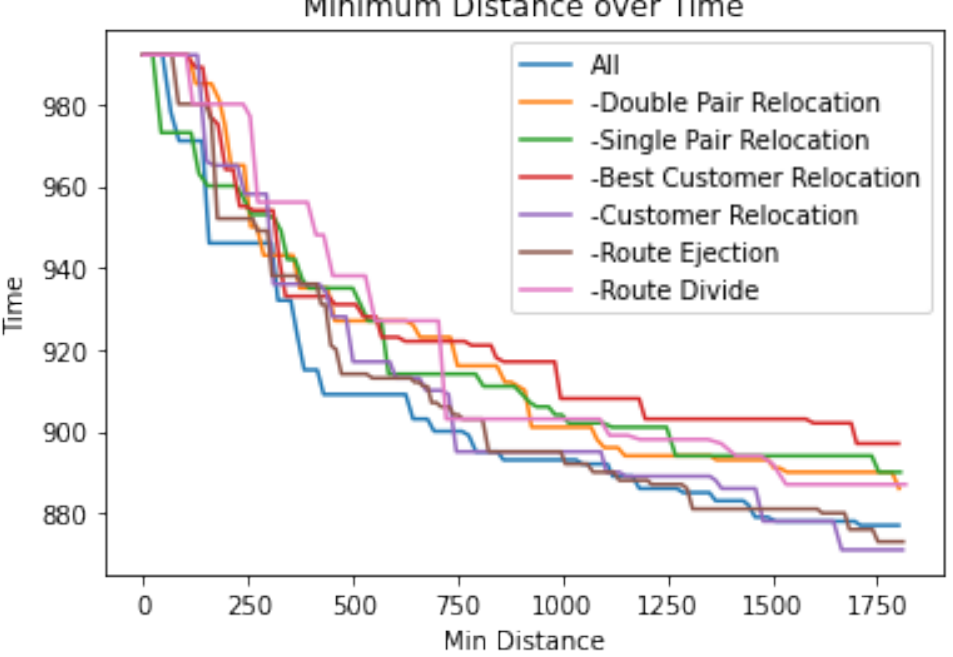
Figure 4. Minimum distance after removing each inter-route